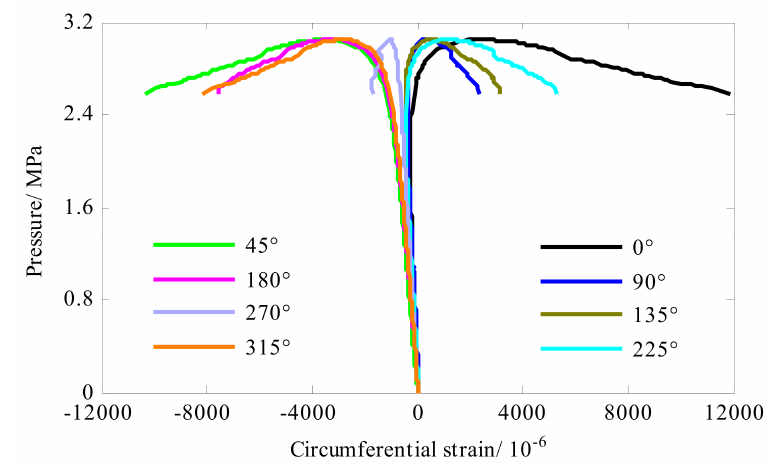
Figure 8. Strain response of the composite cylindrical shell A#.